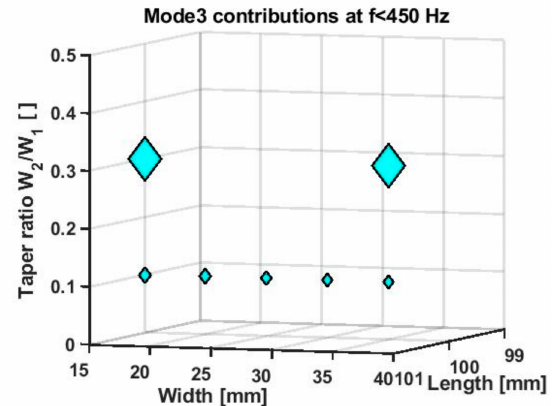
Figure 11. Tendency graph of the contribution of the third mode for structures whose third resonant mode is below 450